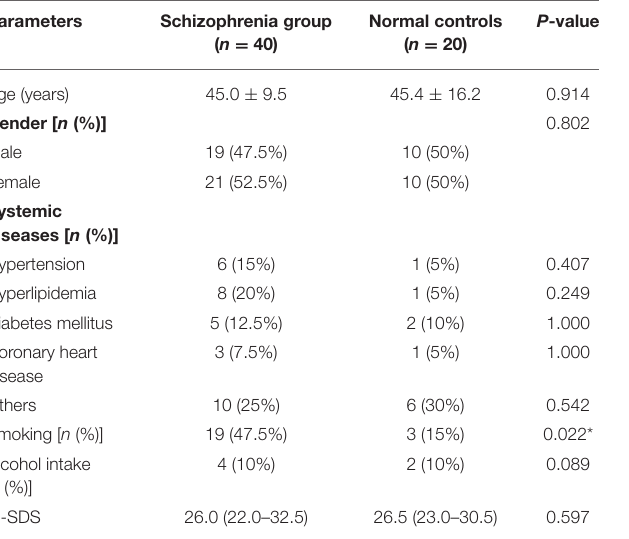
TABLE 1 | Characteristics and basic medical history of schizophrenic patients and normal controls. Parameters